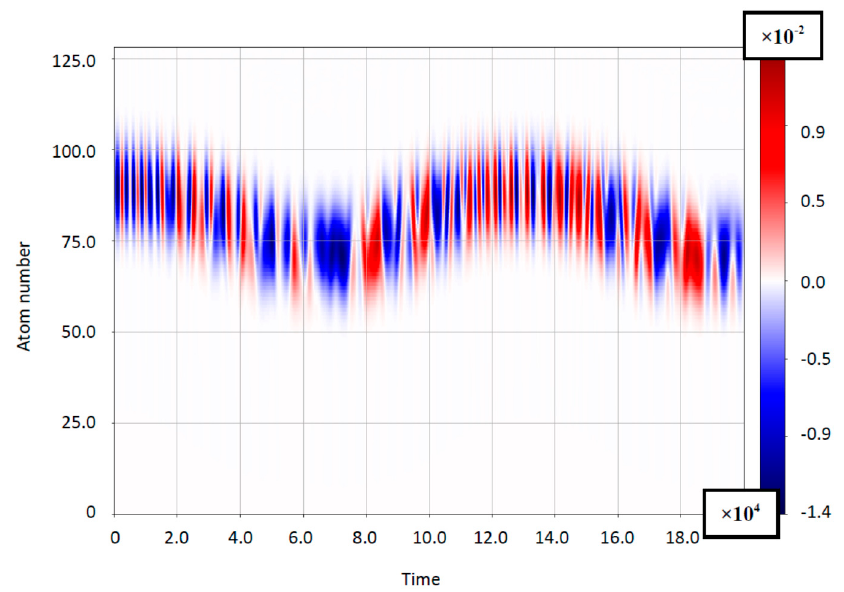
Figure 7. Space–time distribution of the dipole moment density with RO and BO in the separated frequency ranges. All parameters are identical to Figure 3.